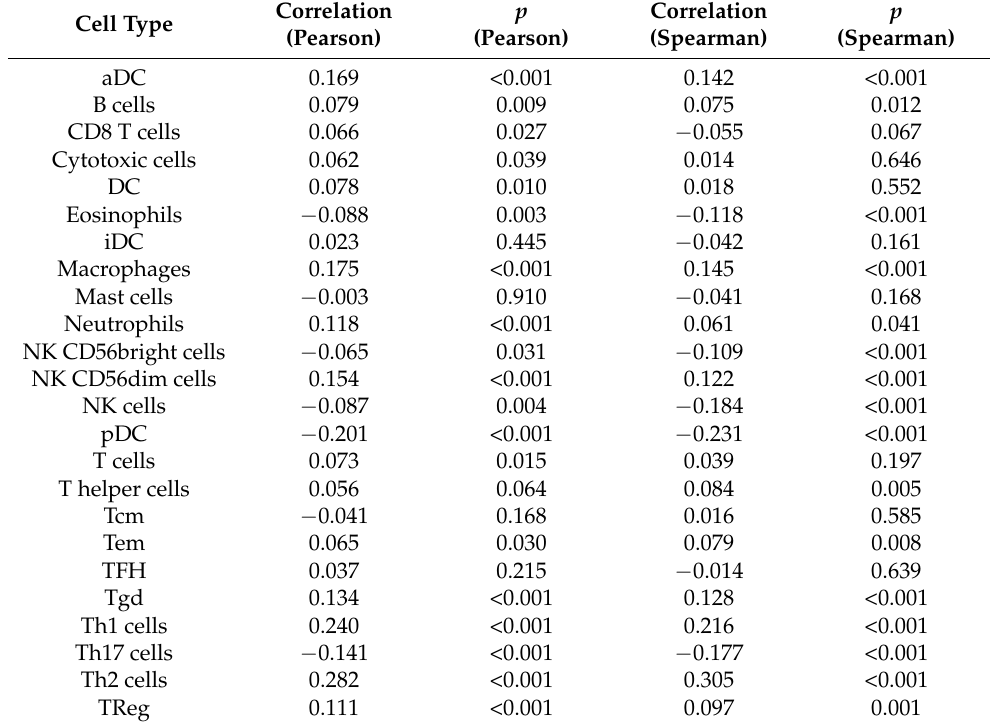
Table 2. CISD1 expression correlation with immune cells